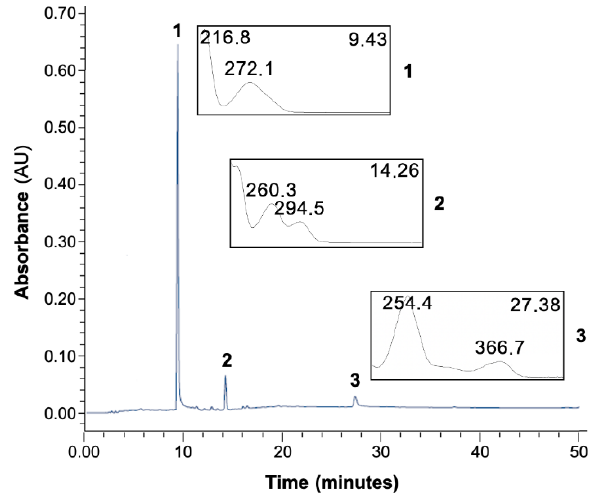
Figure 1. Representative HPLC-UV/DAD chromatographic profile for the AoBTHP. 1: gallic acid; 2: protocatechuic acid; 3: ellagic acid.